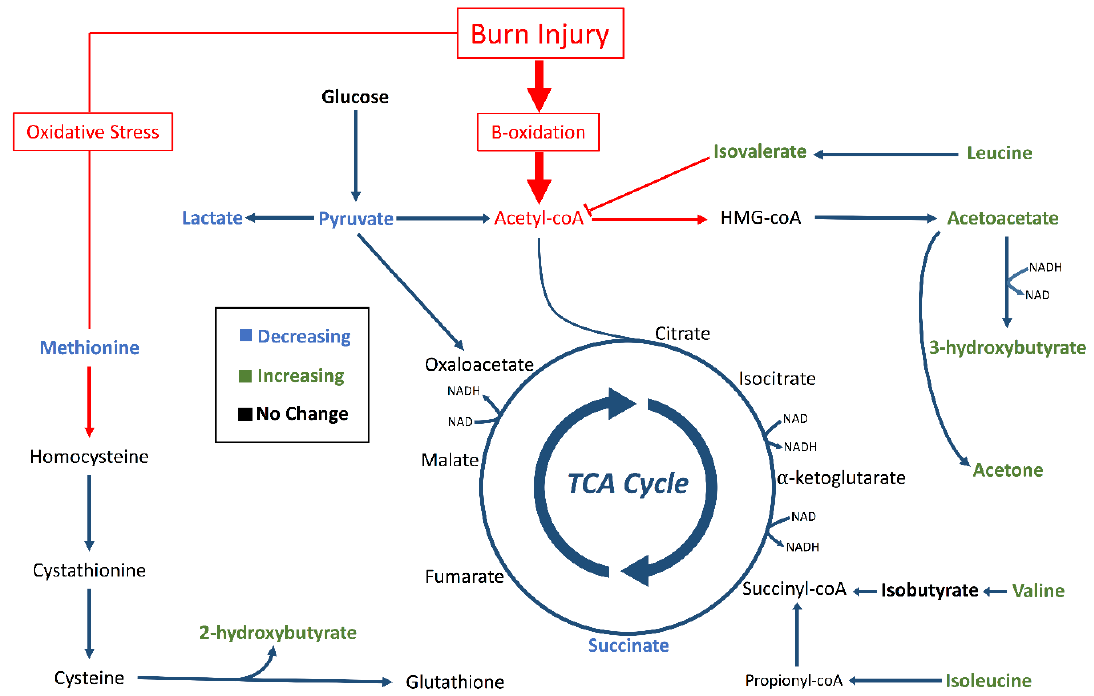
Figure 5. Metabolic pathways altered by burn injury. Pathways for ketogenesis, the TCA cycle, and transsulfuration for glutathione synthesis were outlined with focus on metabolites identified by in our analysis (bold). Green metabolites had significantly increasing concentration trends ( p < 0.05). Blue metabolites had significantly decreasing concentration trends ( p < 0.05). Black metabolites did not change concentration significantly ( p < 0.05), and non-bolded metabolites were not identified in our analysis. The red arrows and boxes represent possible aberrations due to burn injury that could have resulted in accumulation of 2-hydroxybutyrate, isovalerate, acetoacetate, and 3-hydroxybutyrate.